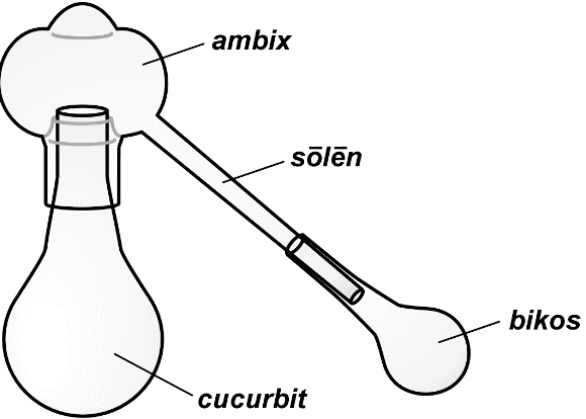
Figure 10. Basic components of the early still [adapted from refer- ence 75 with permission from Springer